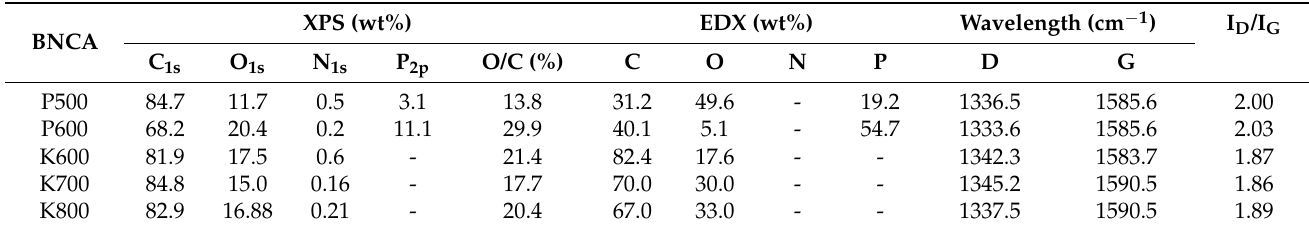
Table 2. Physicochemical properties of BNCA by XPS, SEM-EDX and Raman.